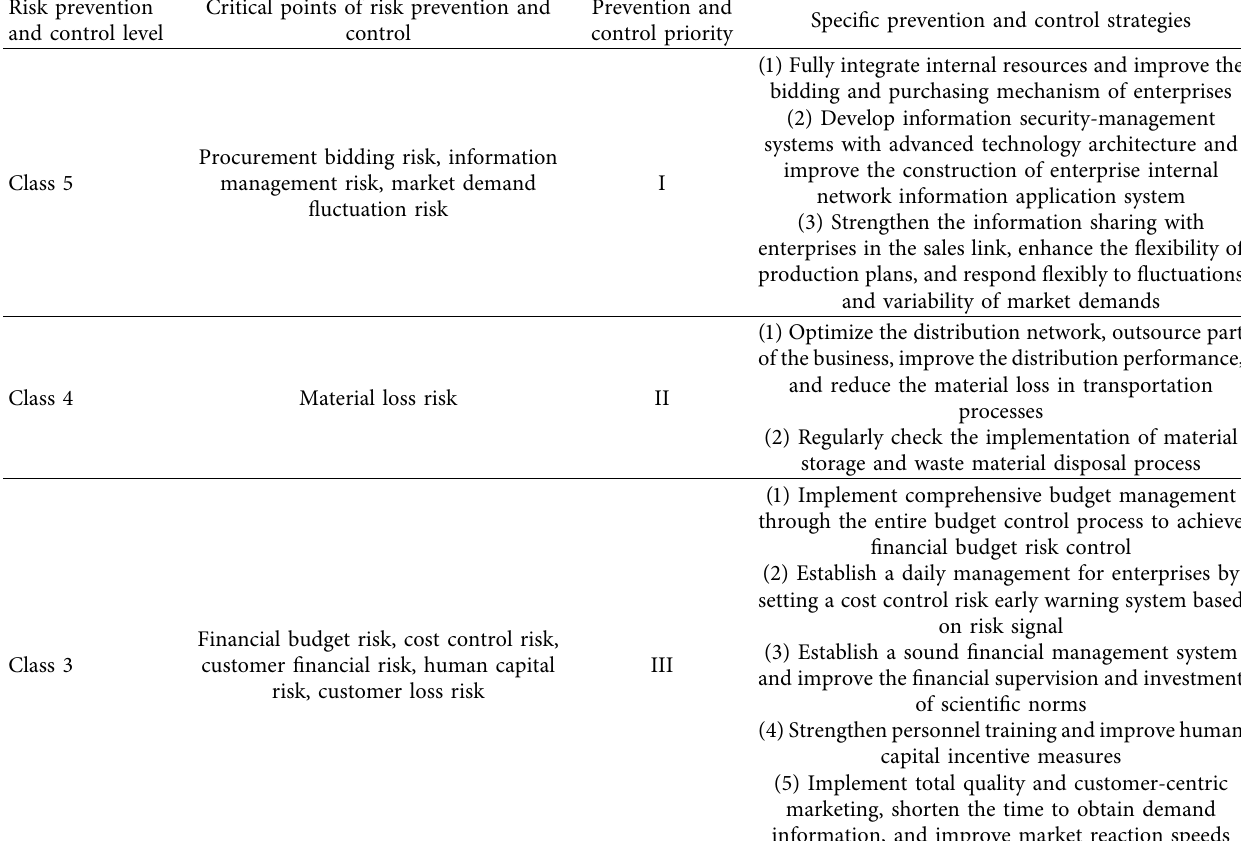
Table 4: Supply chain risk-control strategy for the H